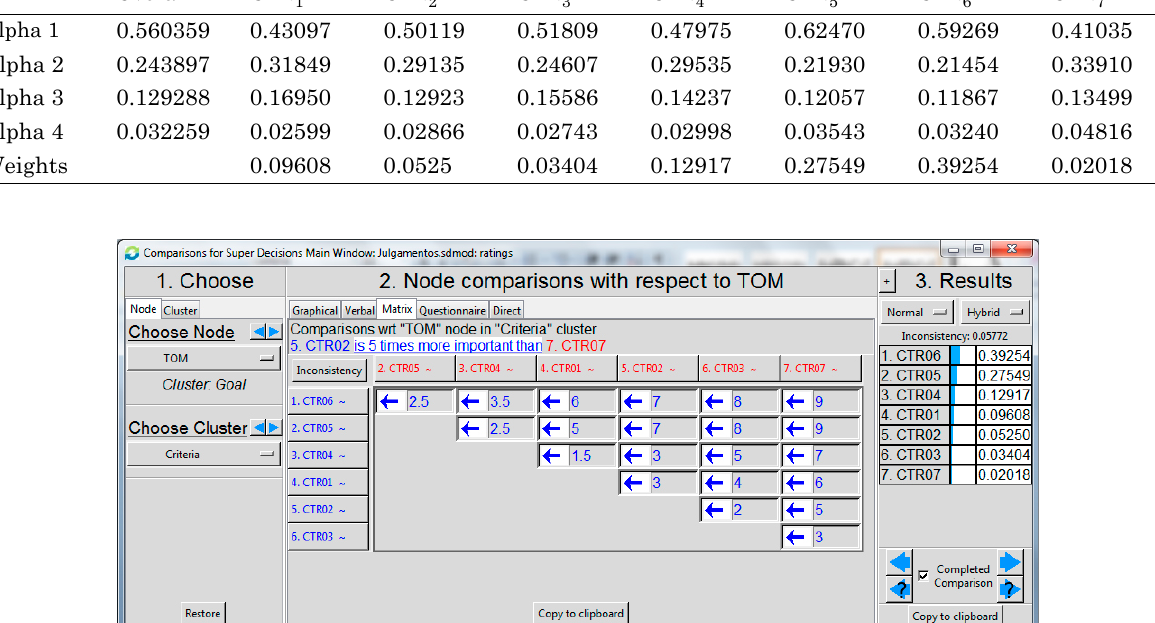
Fig. 5. Judgments matrix and trade-offs of the CTRs